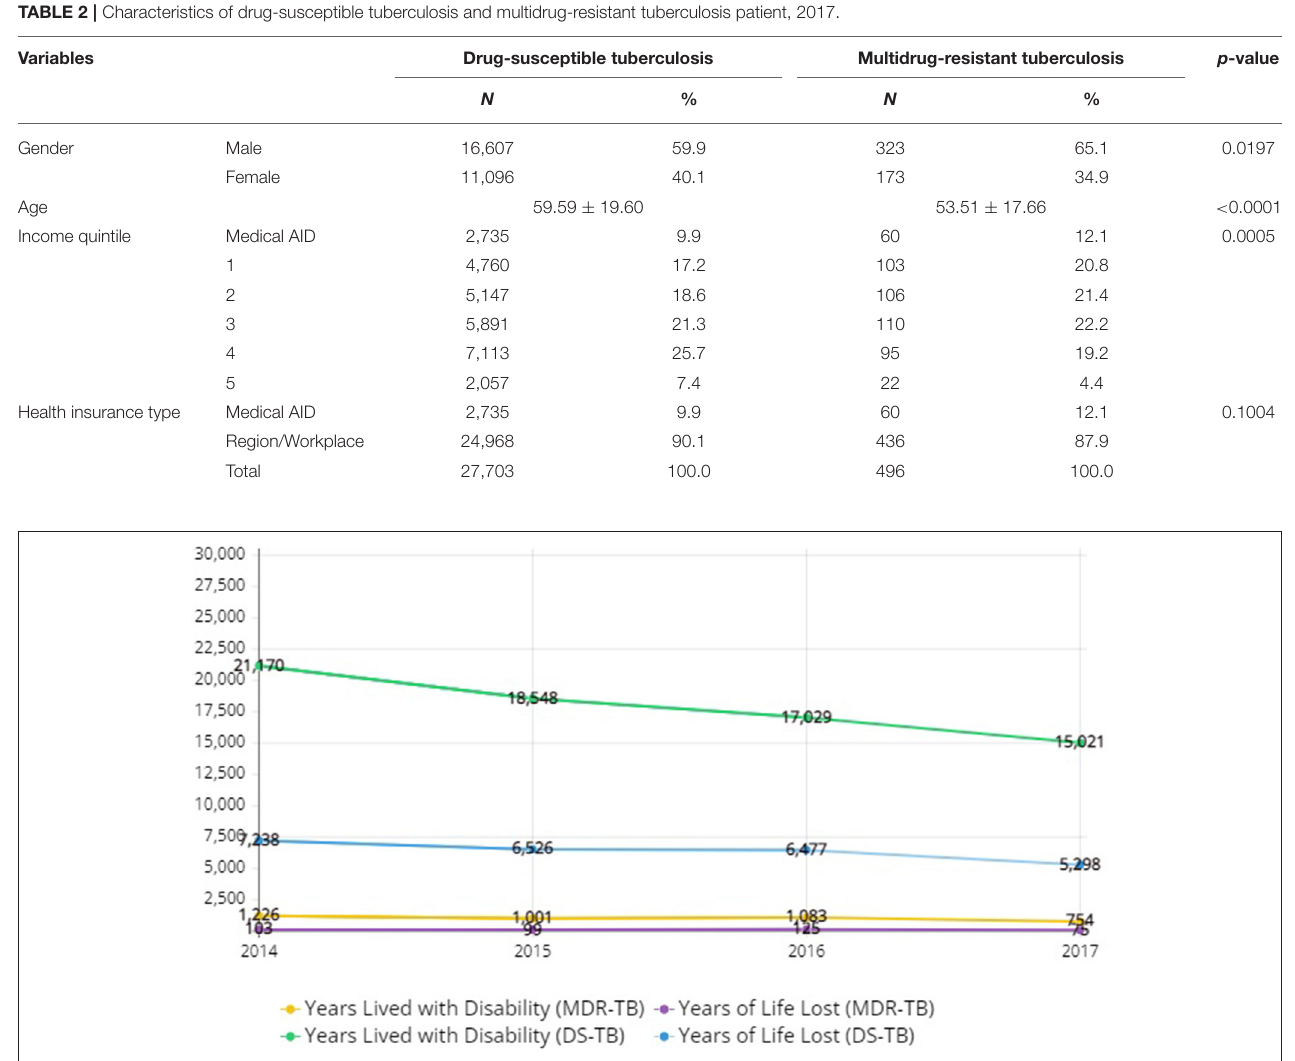
FIGURE 1 | Disability-adjusted life years, years of life lost, years lived with disability due to drug-susceptible tuberculosis and multidrug-resistant tuberculosis in Korea,